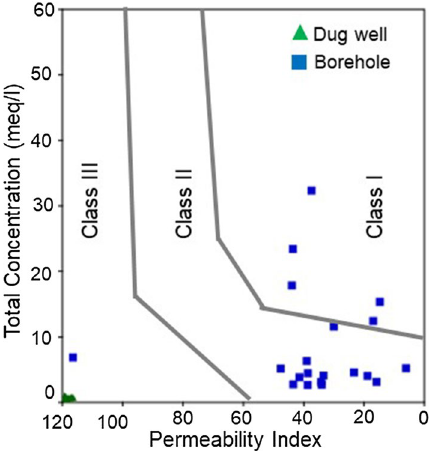
Fig. 14 Doneen’s chart showing groundwater classification of irriga- tion water based on